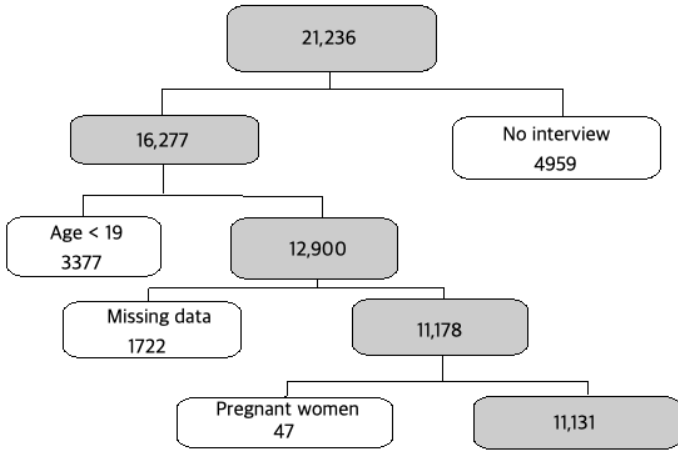
Figure 1. Flowchart showing inclusion and exclusion of subjects according to study criteria.